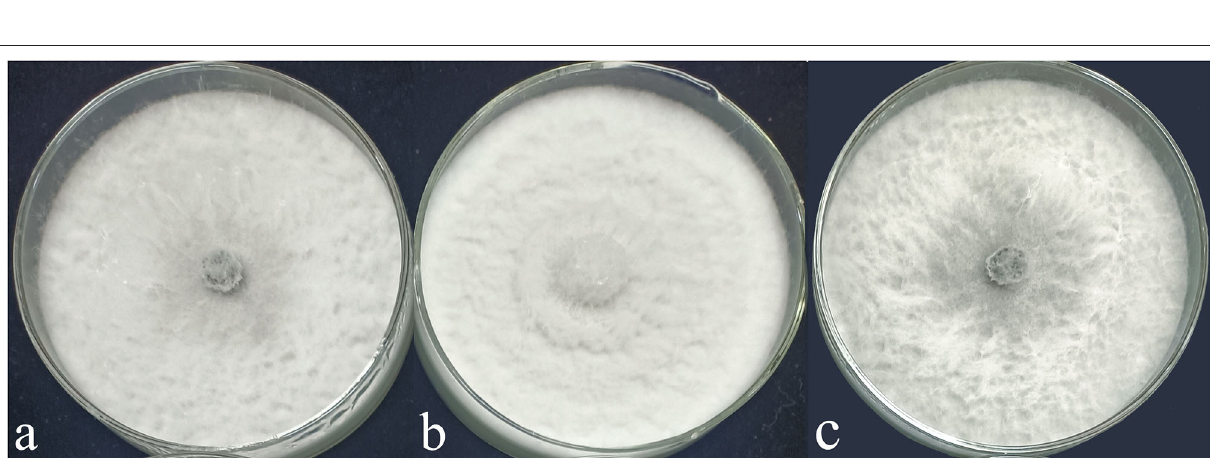
Frontiers in Microbiology | www.frontiersin.org